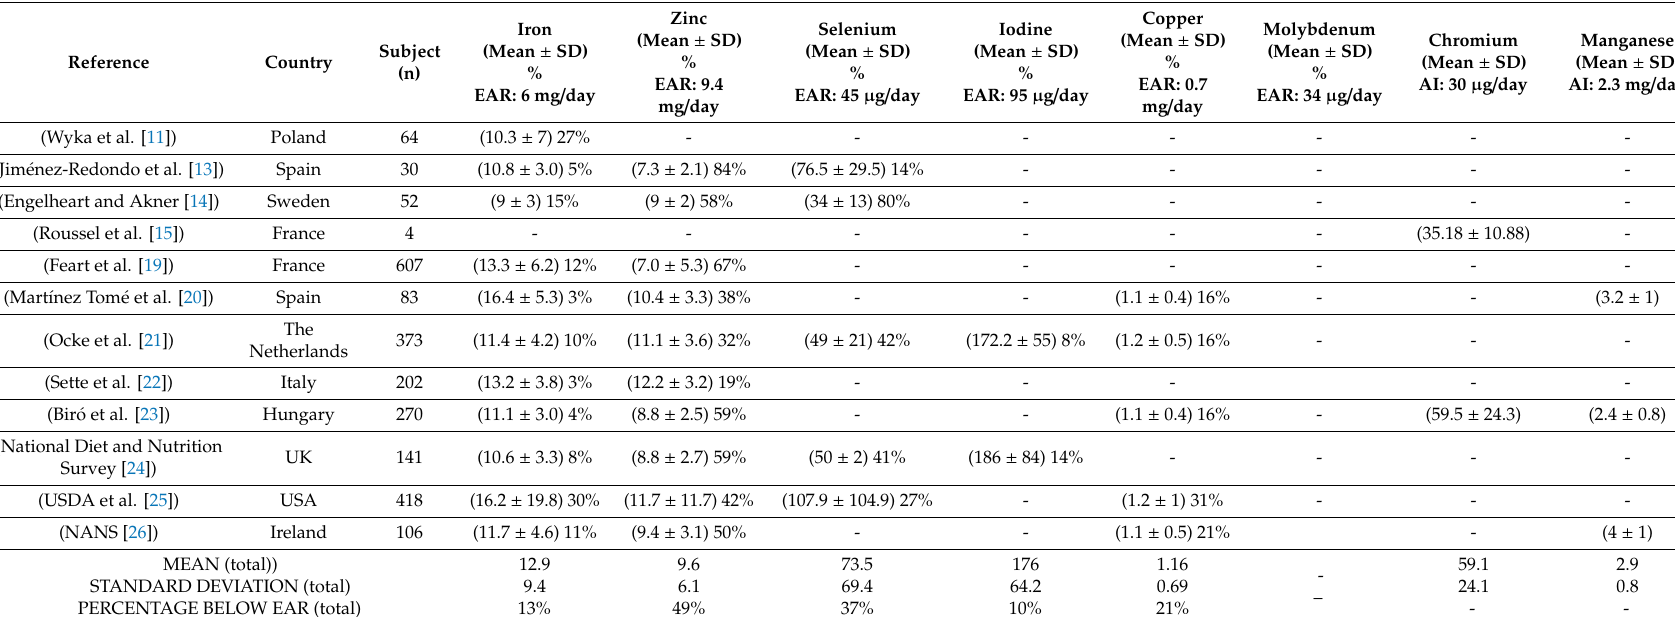
Table 5. Percentage of free-living older men with mineral intakes below the Estimated Average Requirement (EAR) or Adequate Intake (AI) and therefore at increased risk for inadequacy. Mineral intakes are presented as mean + SD. Individual study data and percentage of the free-living population at risk for inadequacy, trace mineral intakes among older